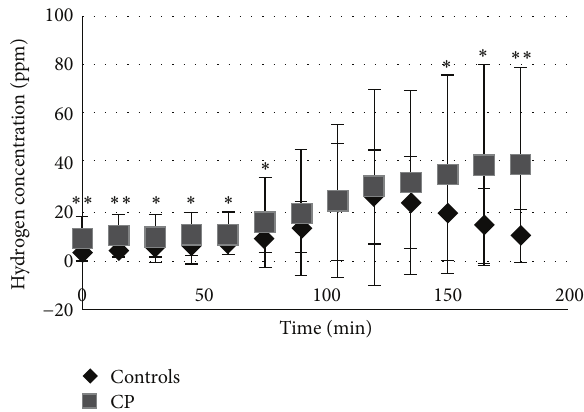
Figure 3: Mean ± SD values of exhaled hydrogen concentration (parts per million (ppm)) during lactulose breath test (LBT). Comparison of the mean curves and SD of exhaled hydrogen concentration of LBT between chronic pancreatitis (CP) patients and controls; ∗ 𝑃 < 0.05; ∗∗ 𝑃 < 0.0001